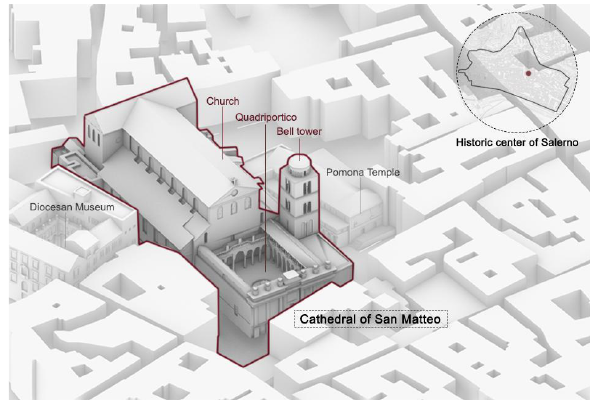
Figure 1 . The Cathedral of San Matteo in the historical center of Salerno.